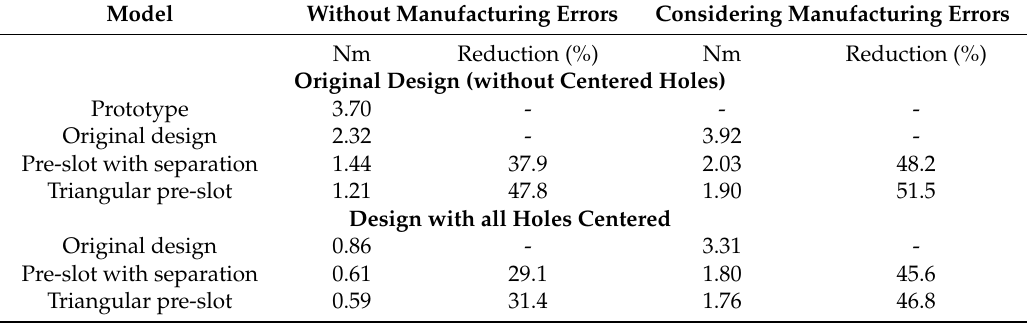
Table 3. Comparison of the maximum cogging torque values obtained for the prototype and the different models considered in the study.